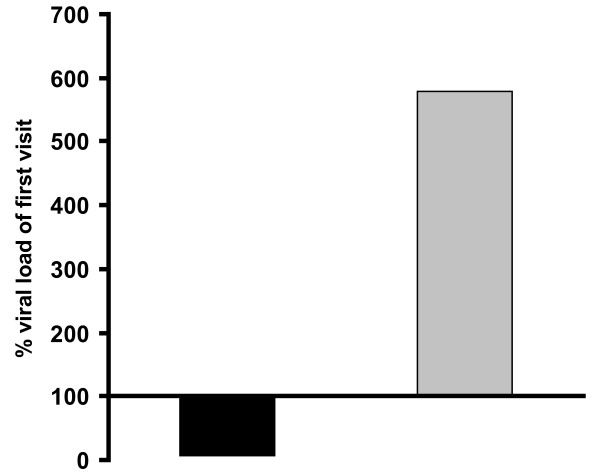
Relative viral load at day 3/4 in % of day 1. Shown is the relative viral load on day 3/4 in percent of the viral load on day 1. The mean of the ct values at visit 1 was set 100% for both Iota-Carrageenan and placebo and the percent of the ct values on day 3/4 was calculated as described in materials and methods. The ct numbers of Iota-Carrageenan and placebo samples of day 1 and day 3/4 were compared by applying a Mann-Whitney U-test (p = 0.009). The black bar shows Iota-Carrageenan and the grey bar shows placebo.